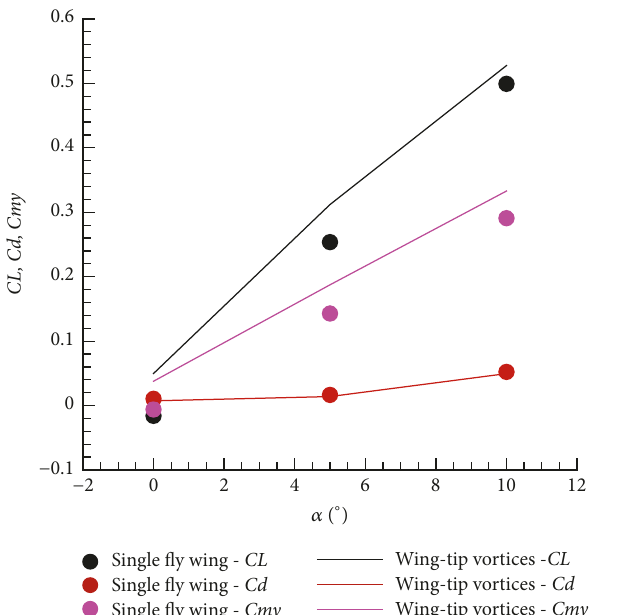
Figure 10: Static derivatives 𝐶 𝑧𝛼 .